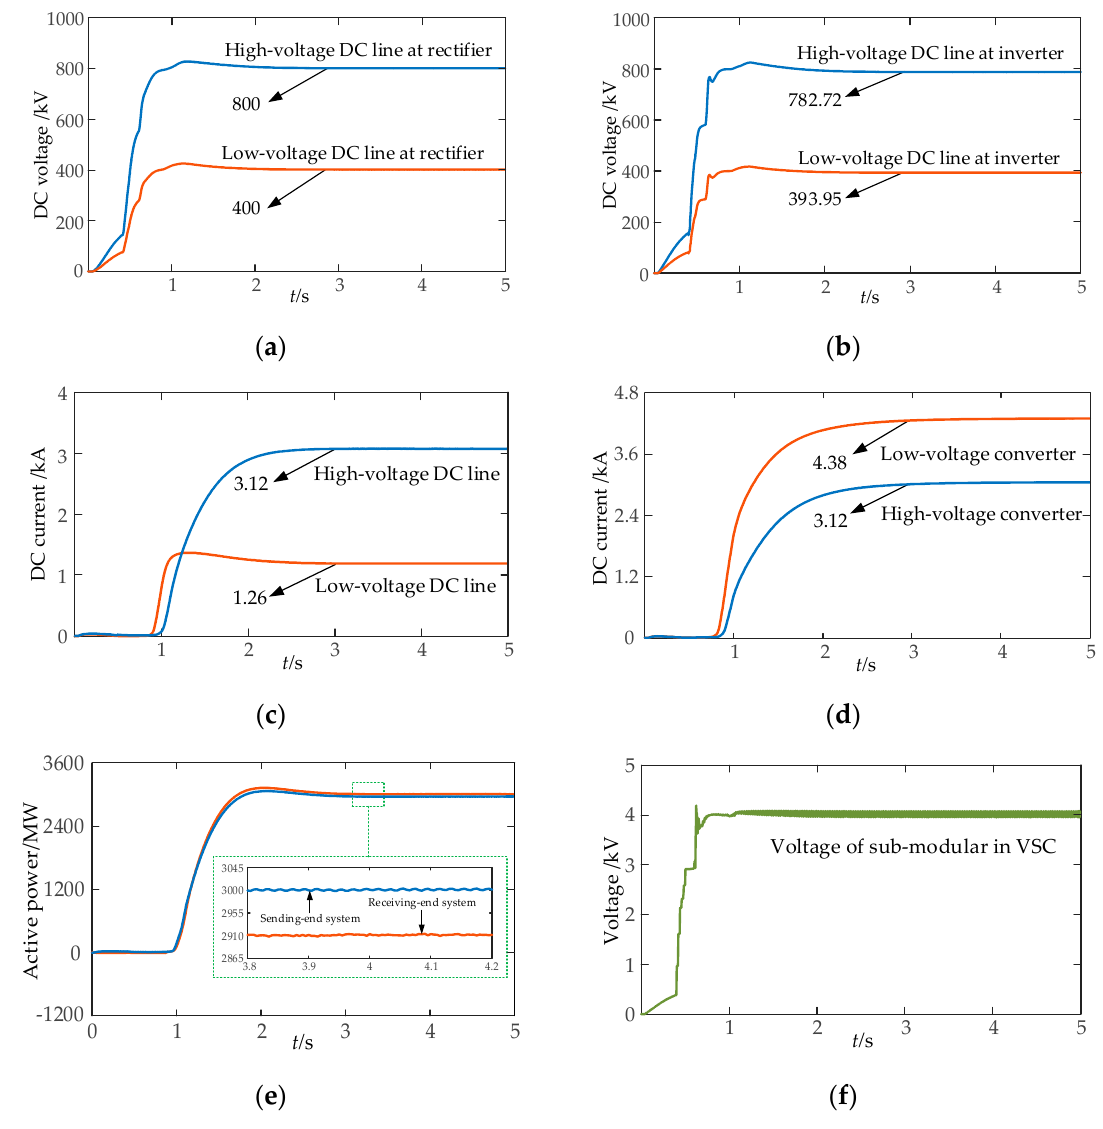
Figure 11. Steady − state waveform of the proposed system. ( a ) DC voltage at rectifier side. ( b ) DC voltage at inverter side. ( c ) DC current of transmission line. ( d ) DC current of converter. ( e ) Active power of HVDC. ( f ) DC voltage of sub − module in VSC.